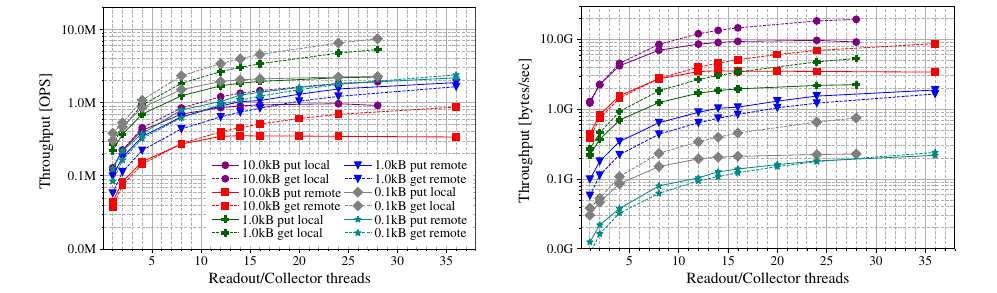
Figure 3. DAQDB throughput (operations per second and bytes per second) for di ff erent number of client threads.